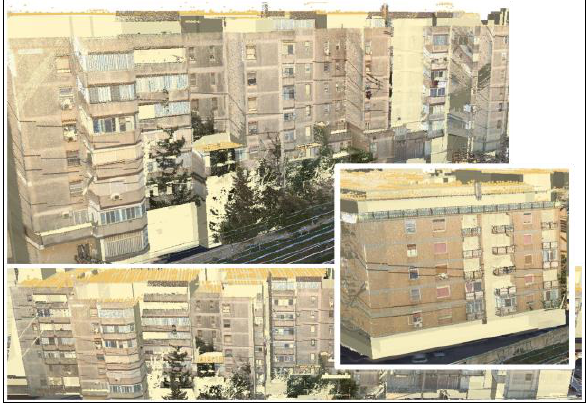
Figure 9 – Point clouds of façades from telemetry